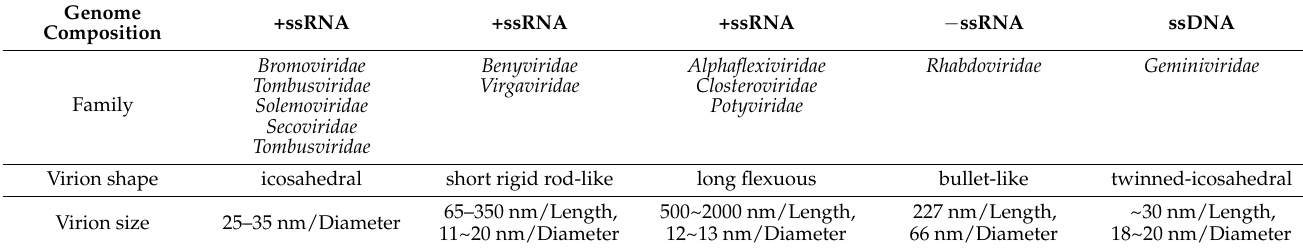
Table 2. Characteristic features of xylem-invading